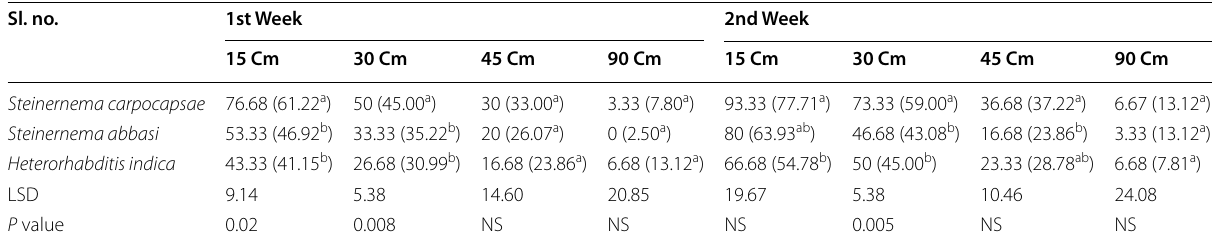
Table 3 Mortality of Oryctes rhinoceros larvae against different entomopathogenic nematode species through penetration study Sl. no.